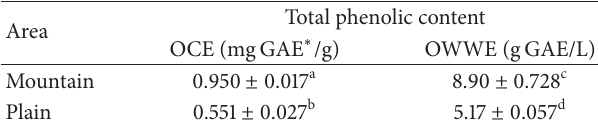
Table 1: Total phenolic content in OCE and OWWE.